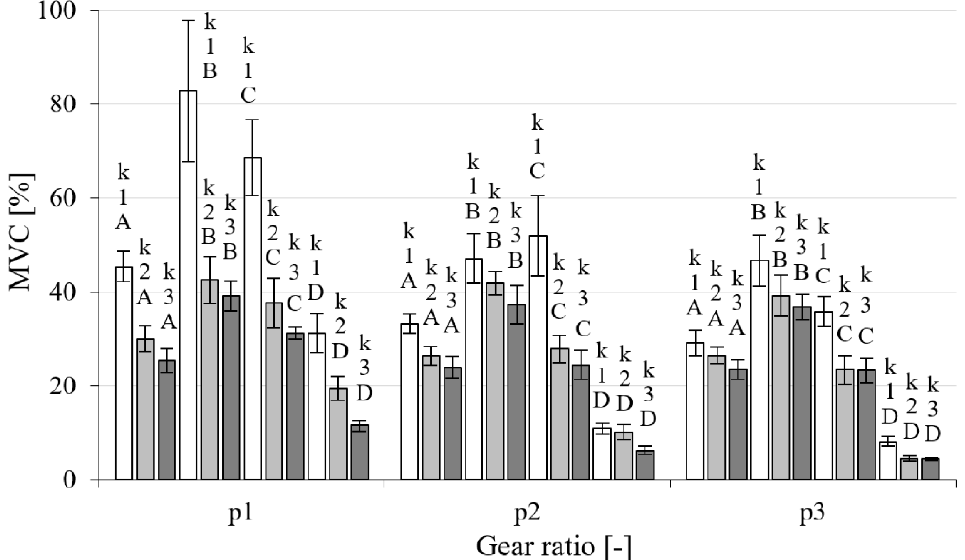
Figure 10. The average EMG signal amplitude values ( 𝑀𝑉𝐶 𝑀𝐴𝑋 ) for all propulsion cycles for measurement tests s2; error bars are ± standard deviation; designations: p1 – 3 — the gear ratio, k1 – 3 — the inclination angle, A – D — the type of muscle (as specified in the Test Conditions and Statistical Analysis paragraph).